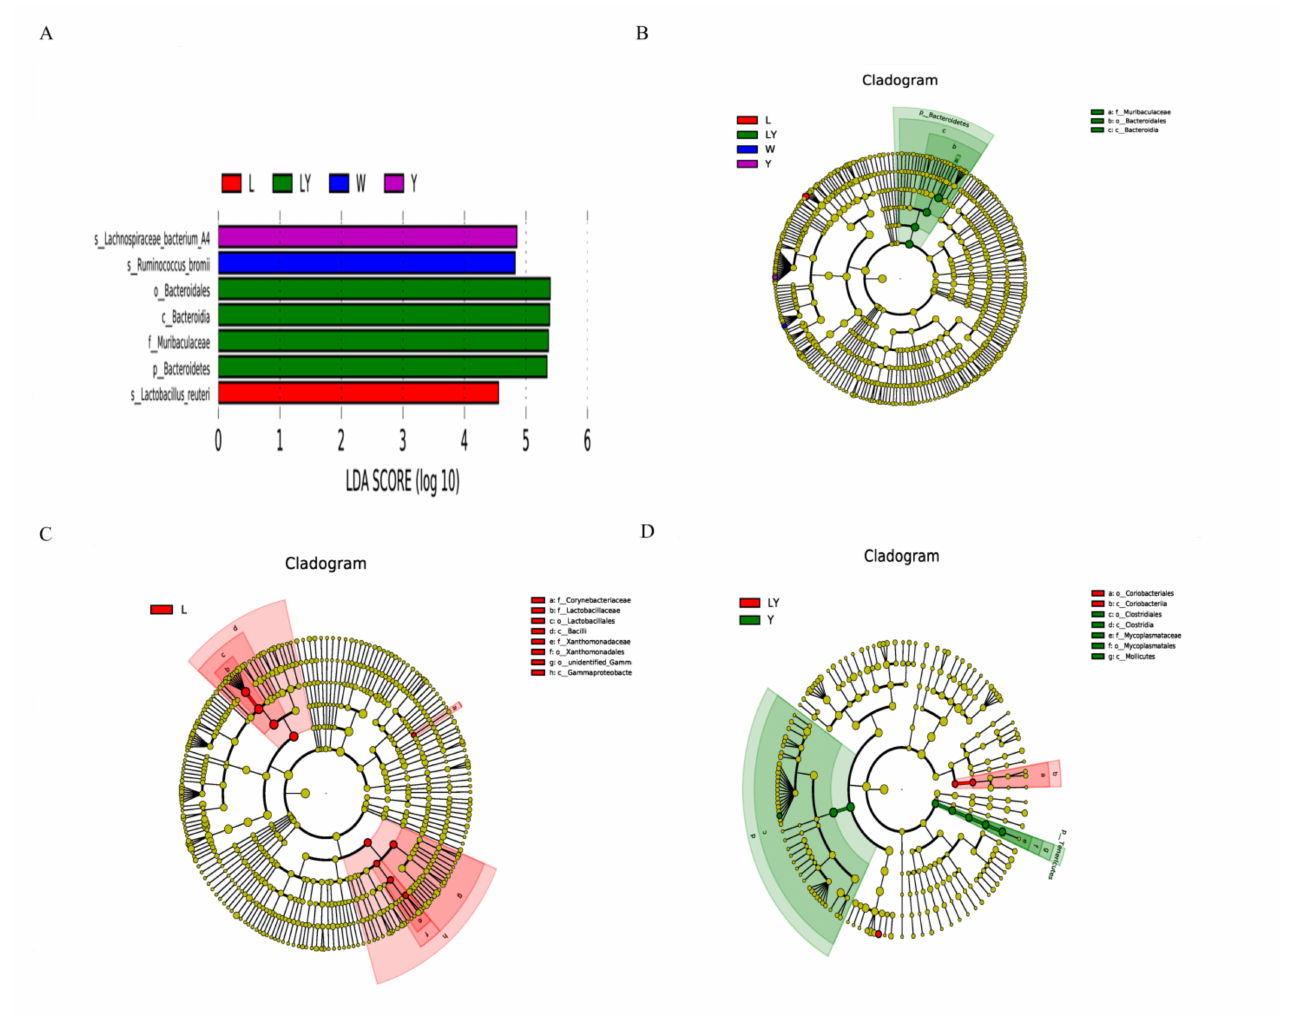
Figure 6. ( A ) Linear discriminant analysis (LDA) discriminant histogram of different experimental groups (L-group, Y-group, LY-group, R-group and W-group), ( B ) LDA Effect Size (LEfSe) multi-level classification tree diagram of different experimental groups (L-group, Y-group, LY-group, R-group and W-group), ( C ) LEfSe multi-level classification tree diagram of L-group and LY-group, ( D ) LEfSe multi-level classification tree diagram of Y-group and